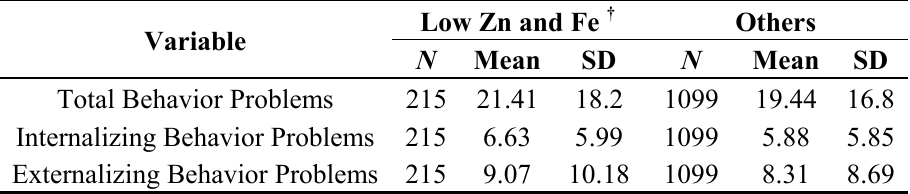
Table 4. Children’s behavior problems by Zn and Fe level ( N =